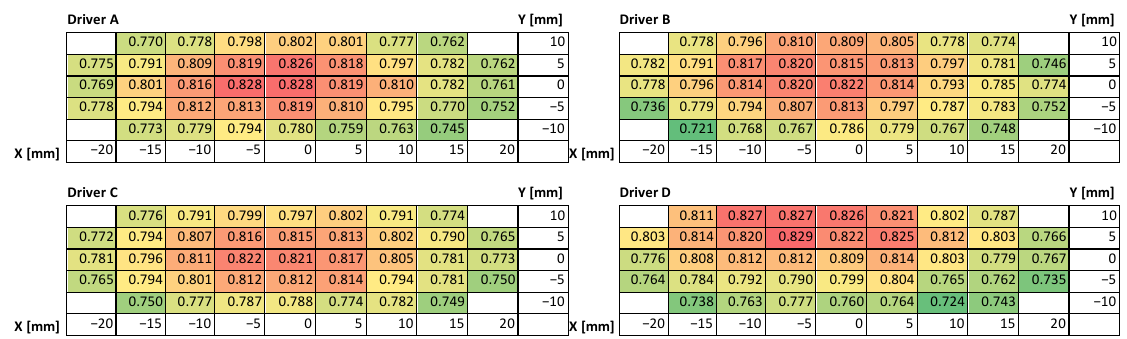
Table 1. COR Maps for drivers A, B, C, and D.